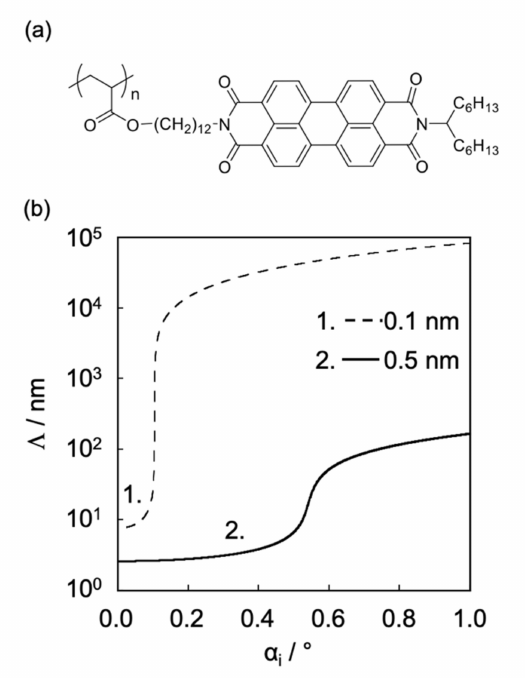
Figure 5. ( a ) Chemical structure of PAc12PDI. ( b ) X-ray penetration depth profiles of PAc12PDI thin films using hard (0.1 nm, 12.4 keV) and tender X-rays (0.5 nm, 2.48 keV). Reproduced with permission [29]. 2018, American Chemical Society.